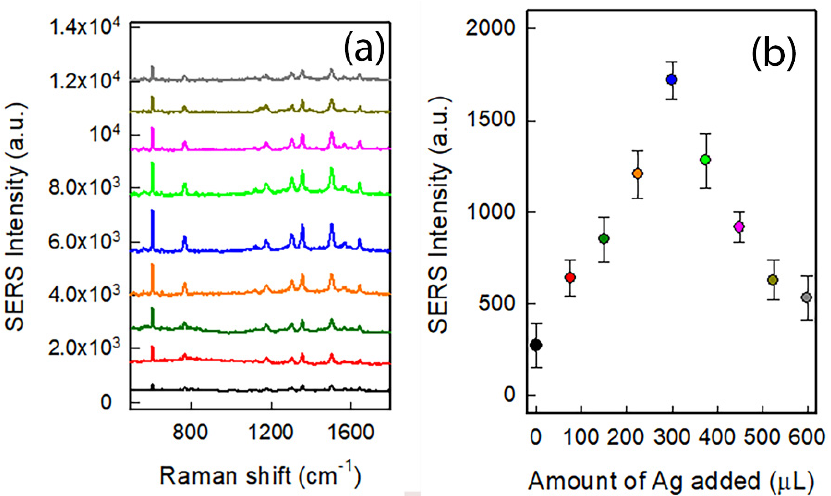
Figure 3. ( a ) SERS spectra of 10–5 M solution of R6G obtained in presence of colloidal suspensions of GNS (black line), GNS@Ag75 (red), GNS@Ag150 (dark green), GNS@Ag225 (orange) GNS@Ag300 (blue), GNS@Ag375 (green), GNS@Ag450 (pink), GNS@Ag525 (dark yellow), GNS@Ag600 (grey); ( b ) SERS intensity of mode at 610 cm − 1 of R6G as a function of silver amount added to form the coating layer.